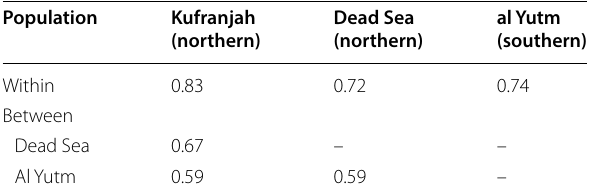
Table 3 Mean values of genetic similarity within and between